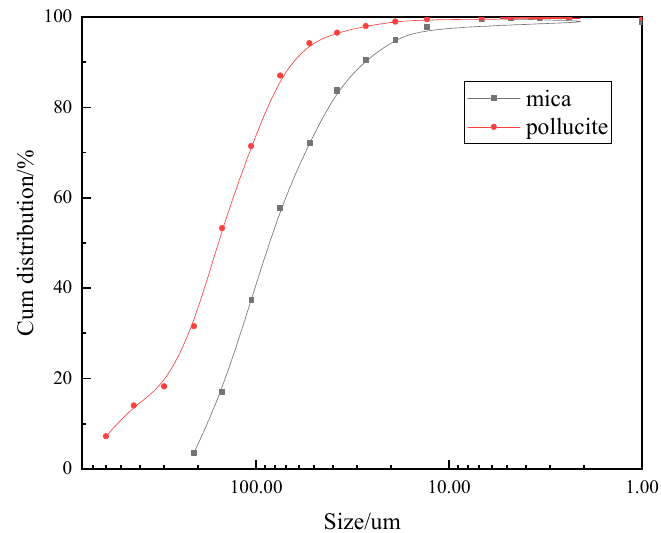
Figure 3. Cumulative distribution curve of particle size of the main cesium-containing minerals.